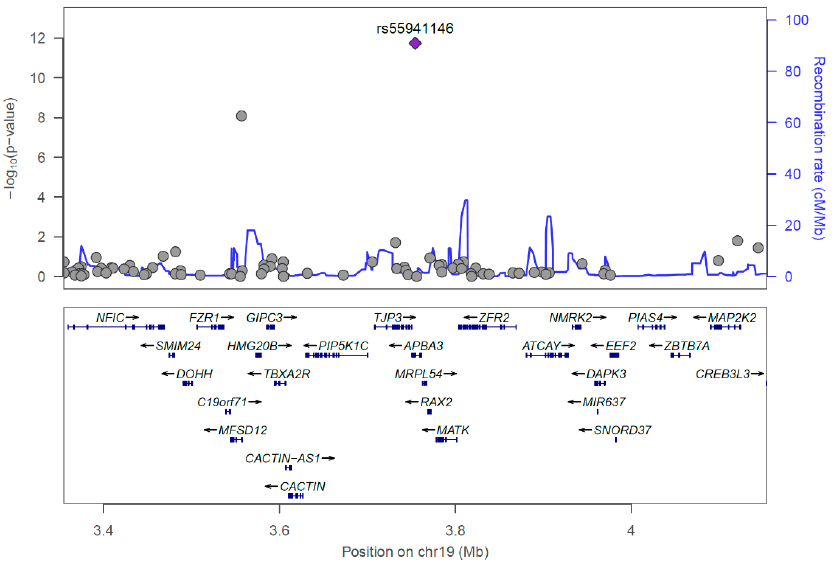
Figure 2. Regional association plot for loci significantly associated with premature ovarian failure in the Korean female population: chr19:3354338 − 4154338 [3354338 − 4154338] ( APBA3 ).